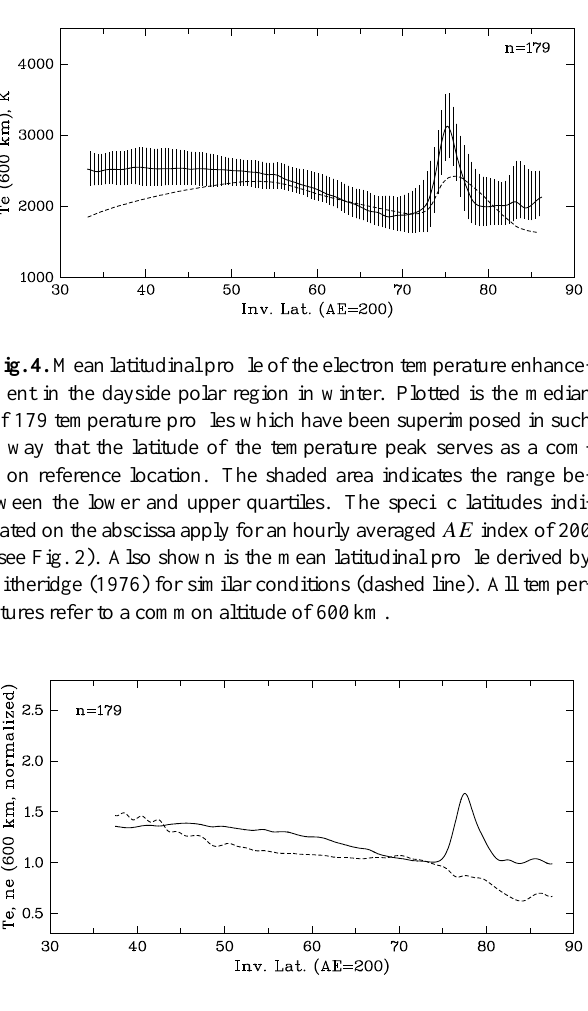
Fig. 5. Comparison of the mean latitudinal profiles of electron tem- perature (solid line) and electron density (dashed line) in the dayside polar region in winter. The format of data presentation is similiar to that used in Fig. 4, except that in addition to the height adjustment, the data have also been normalized. Here the temperature and den- sity recorded at the equatorward boundary of the temperature peak (i.e. at Latf ) served as reference